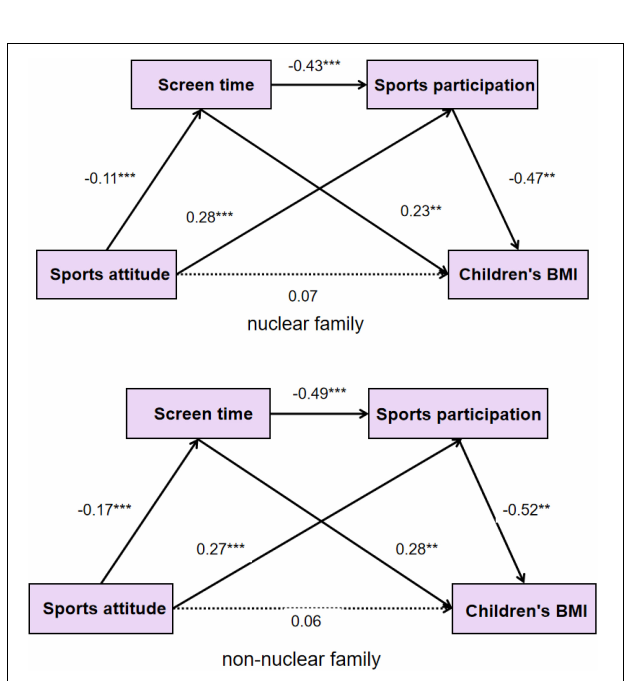
FIGURE 2 | Path relationship between family sports attitude, sports participation, screen static time, and children’s BMI in different family